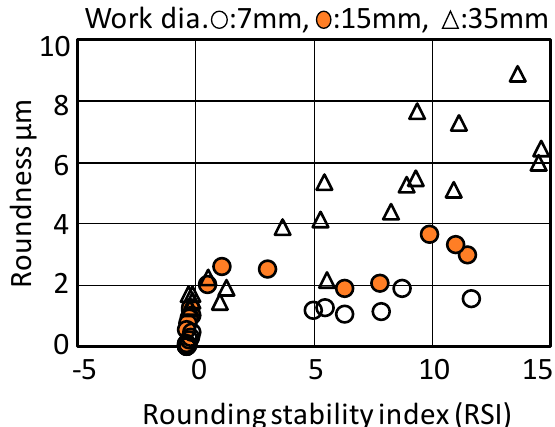
Figure 10. RSI vs. roundness (simulation).